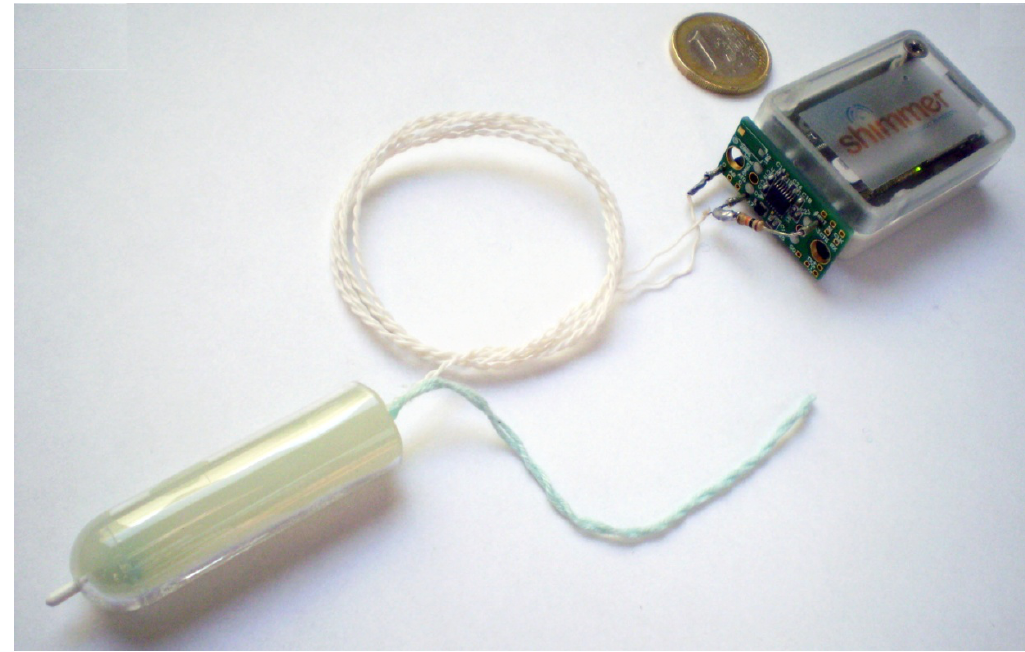
Figure 4. Developed system